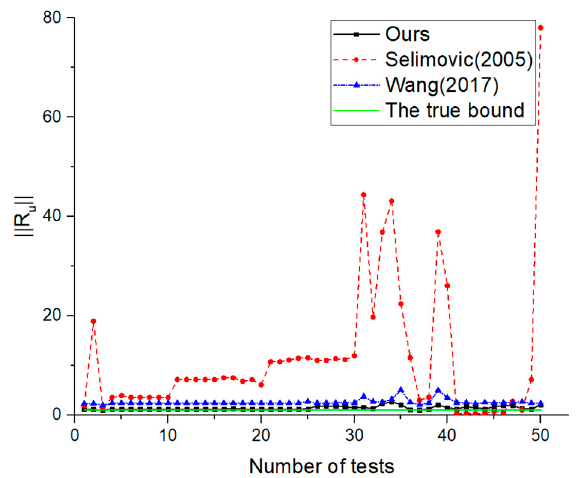
Figure 3. Comparison between bounds on the first-order derivative R u ( u ) of NURBS surfaces with fixed control points, fixed weights and randomly selected knot vectors.